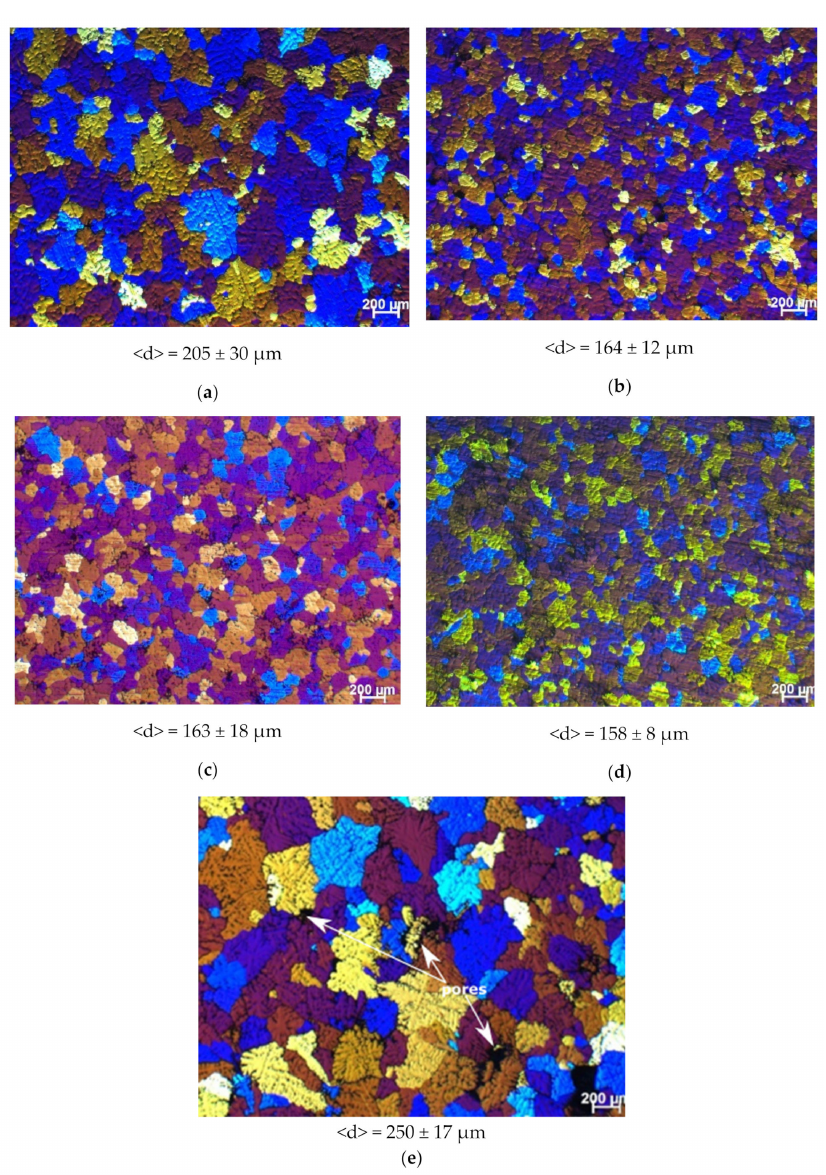
Figure 6. Microstructure of obtained alloys: AA5056 reference ultrasonic (US) ( a ), AA5056 + MA1 US ( b ), AA5056 + MA2 US ( c ), AA5056 + MA3 US ( d ), AA5056 + MA1 without US ( e